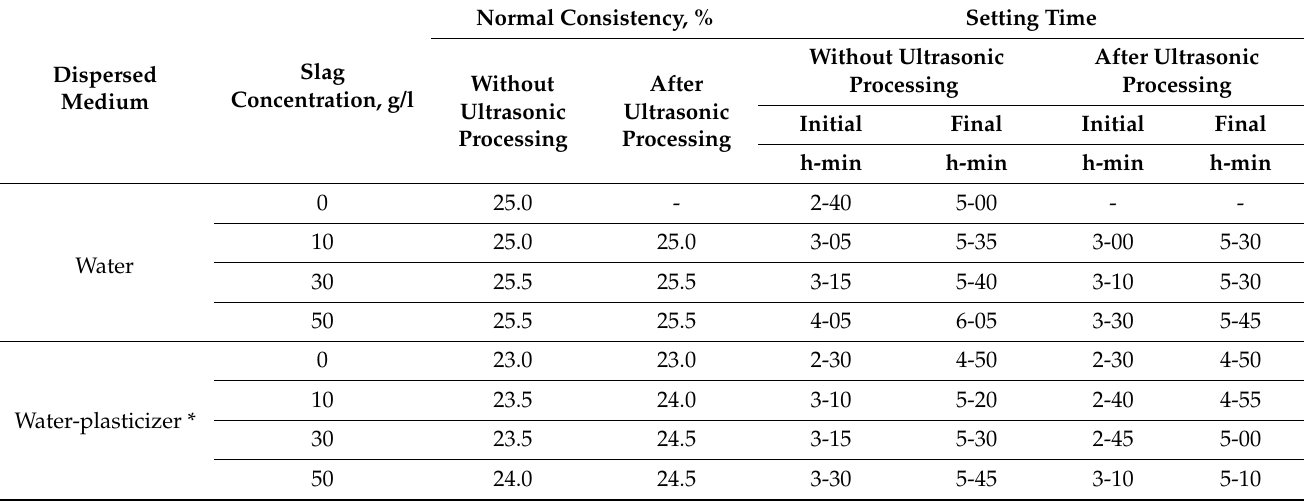
Table 23. Construction and technical properties of cement mortar based on OPC with slag suspension.